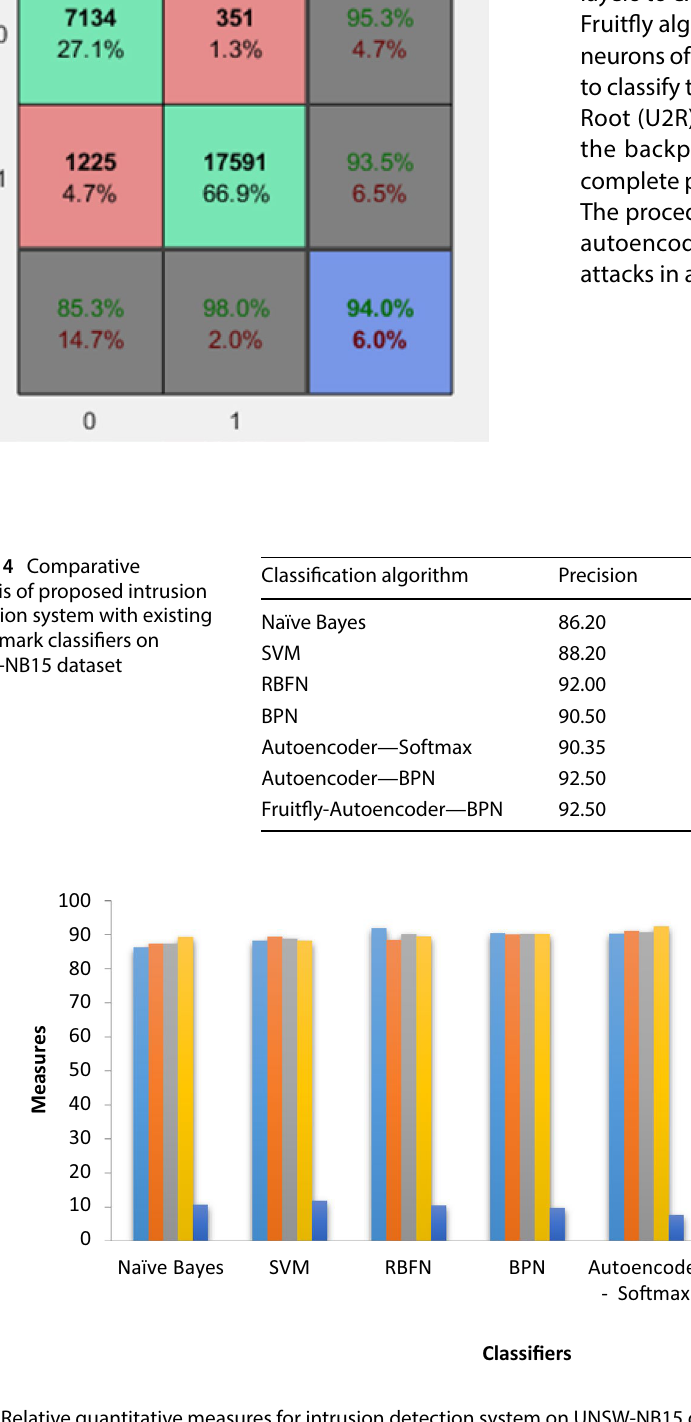
Fig. 7 Relative quantitative measures for intrusion detection system on UNSW-NB15